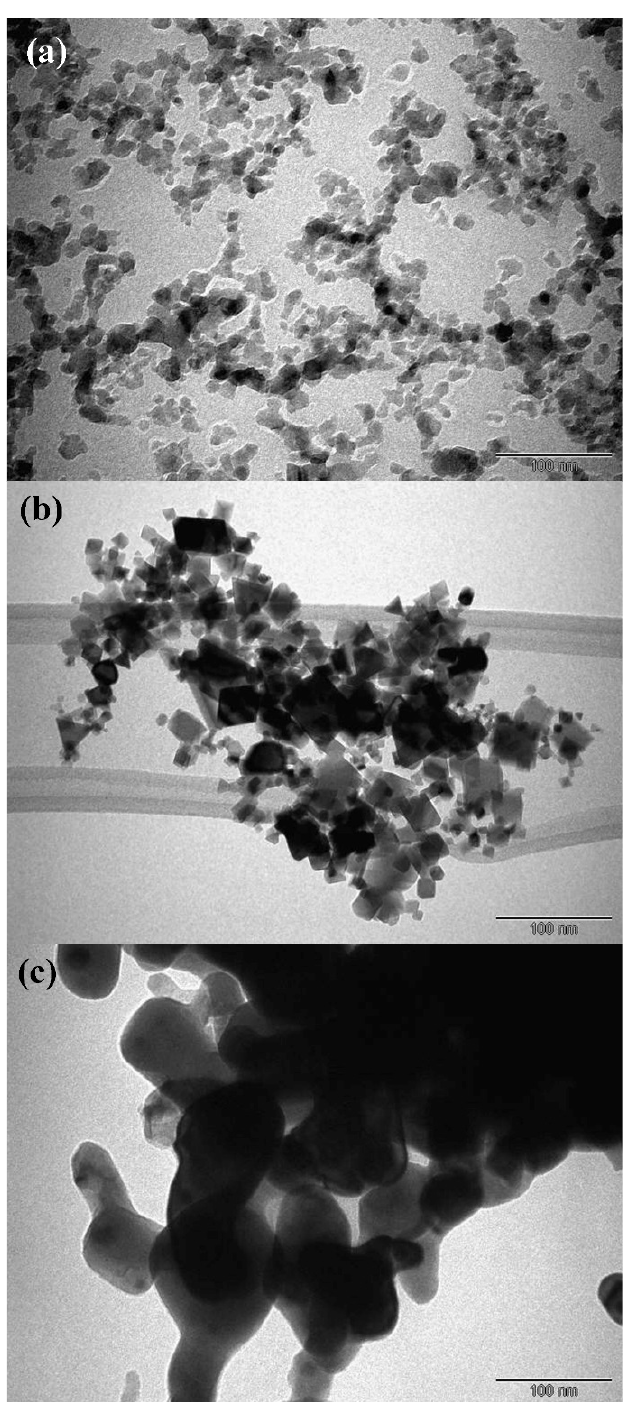
Figure 3. TEM micrographs of ( a ) Al 2 O 3 , ( b ) CeO 2 , and ( c ) AlCeO 3 nanopowders.